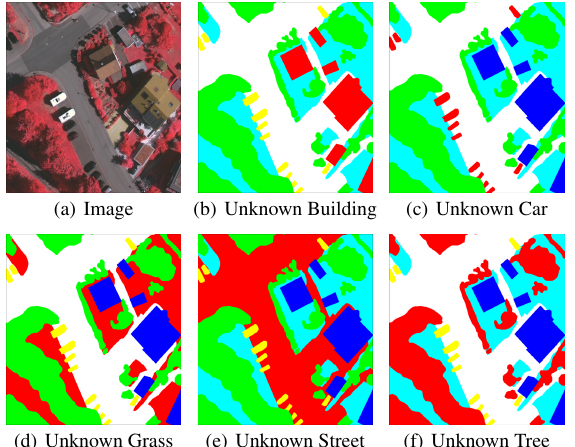
Figure 3. Representation of the protocol used to vary the unknown class during the